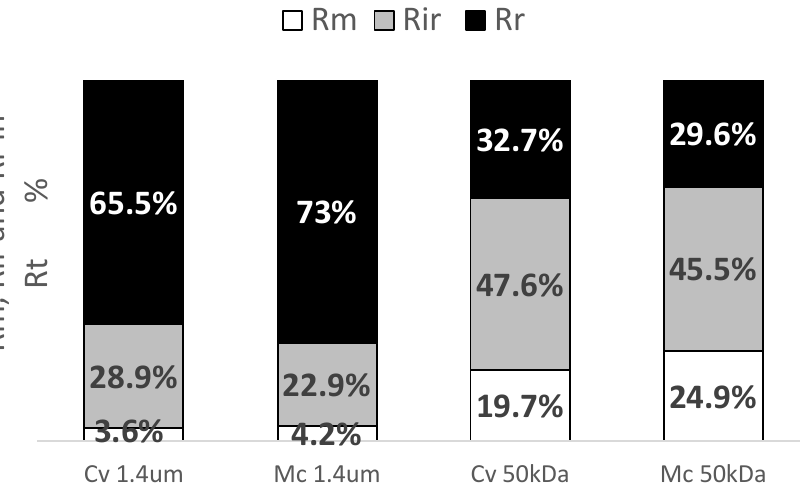
Figure 5. Percentage of resistance (R m -membrane resistance; R ir -irreversible resistance; R r -reversible resistance) to total hydraulic resistance.